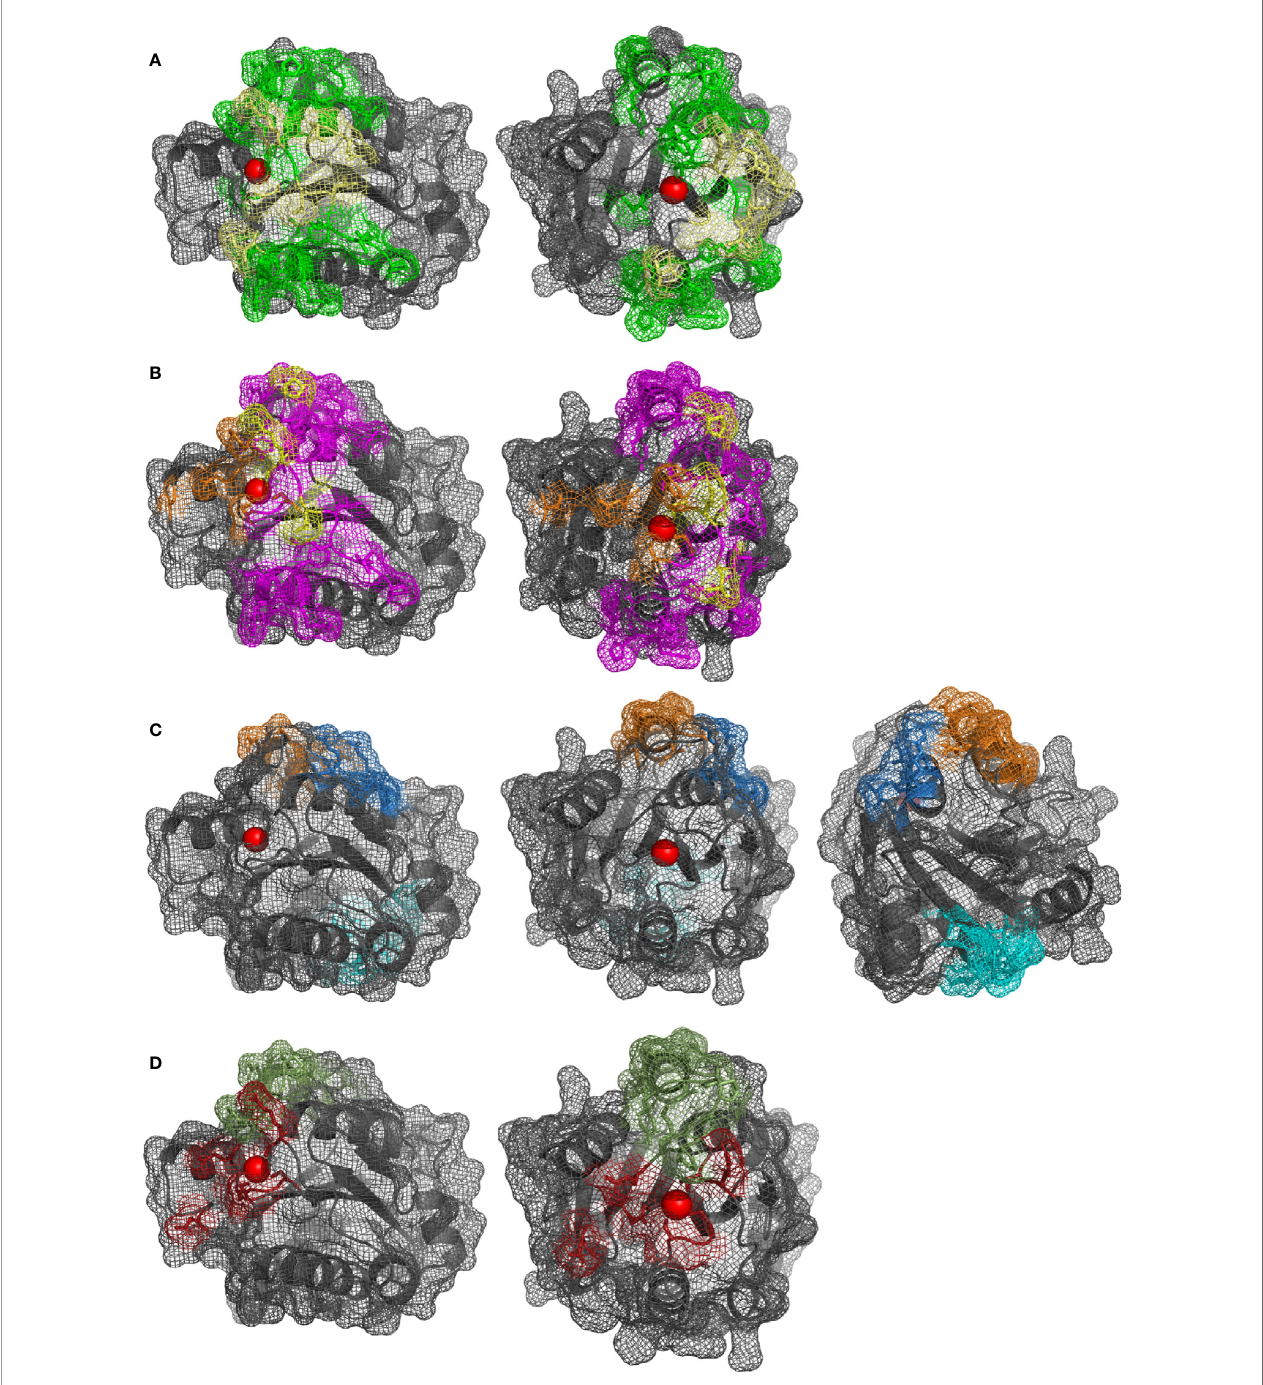
FIGURE 4 | a M I domain (pdb: 1IDO) as cartoon and surface shown as mesh, Mg 2+ in red. Binding sites of ligands reported by mutational, competition, structural or docking studies: (A) iC3b (green), C3d (yellow), (B) NIF (pink), LukGH (orange), (yellow for overlapping), (C) glucosamine (blue), FCgRII (orange), and CD40L and LRP1 (cyan), (D) GPIb a (ruby), fi brinogen